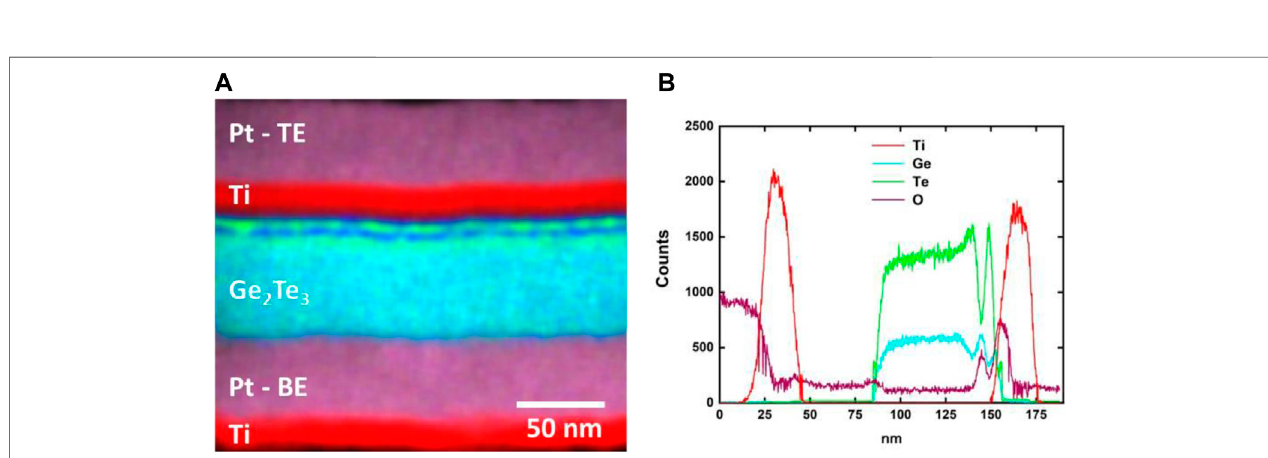
FIGURE 3 | (A) Low resistance state values following DC sweeps at current compliances of 500 µA, 1 mA, 1.5 mA, 2 and 5 mA (black) and high resistance state values following each reset pulse (red) for a single device (B) HRS/LRS ratio for each current compliance.